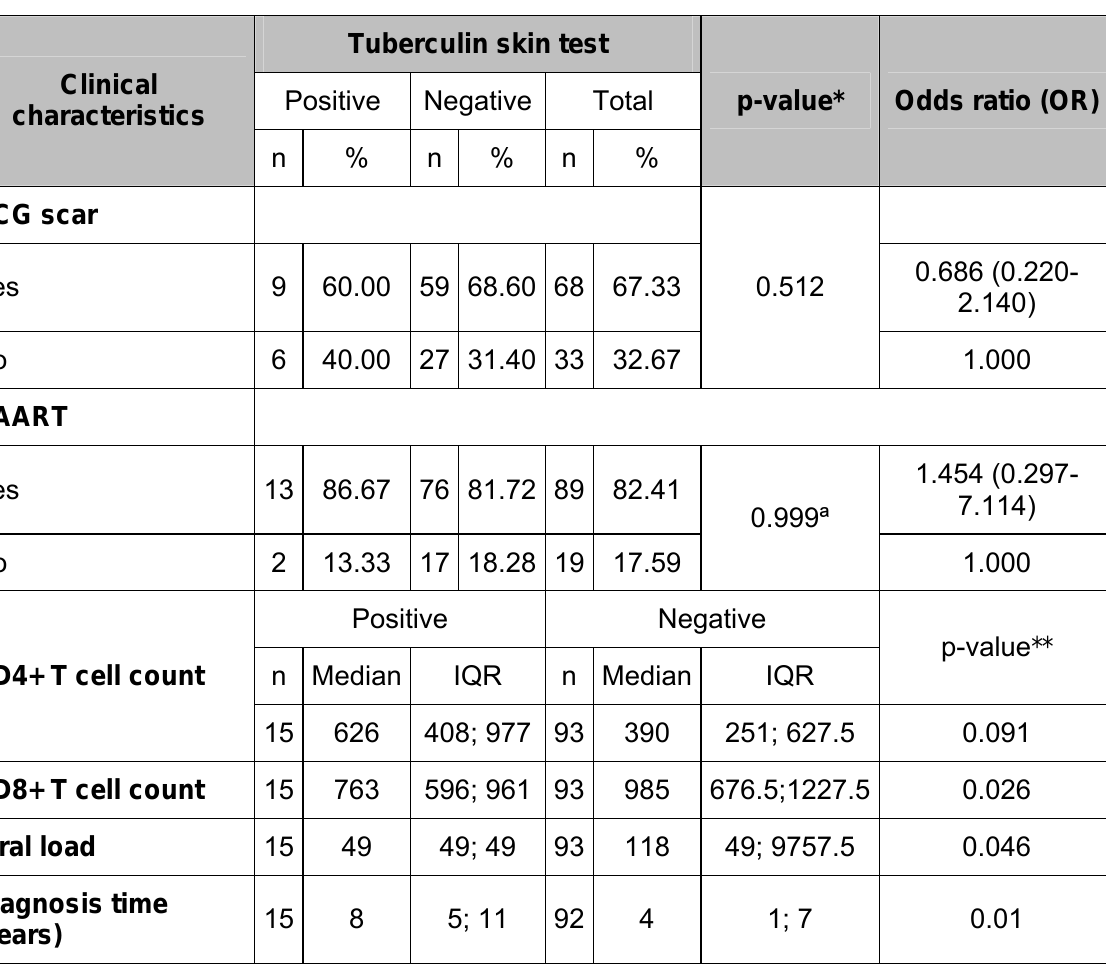
Table 2. Clinical characteristics and tuberculin skin test among HIV/AIDS patients in Campo Grande, Mato Grosso do Sul state, Brazil,